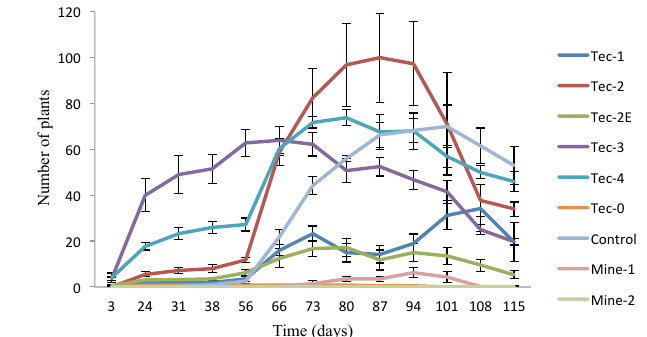
Figure 1 Figure 1. Number of individuals (mean ± SE) in the experimental soils throughout the experiment.